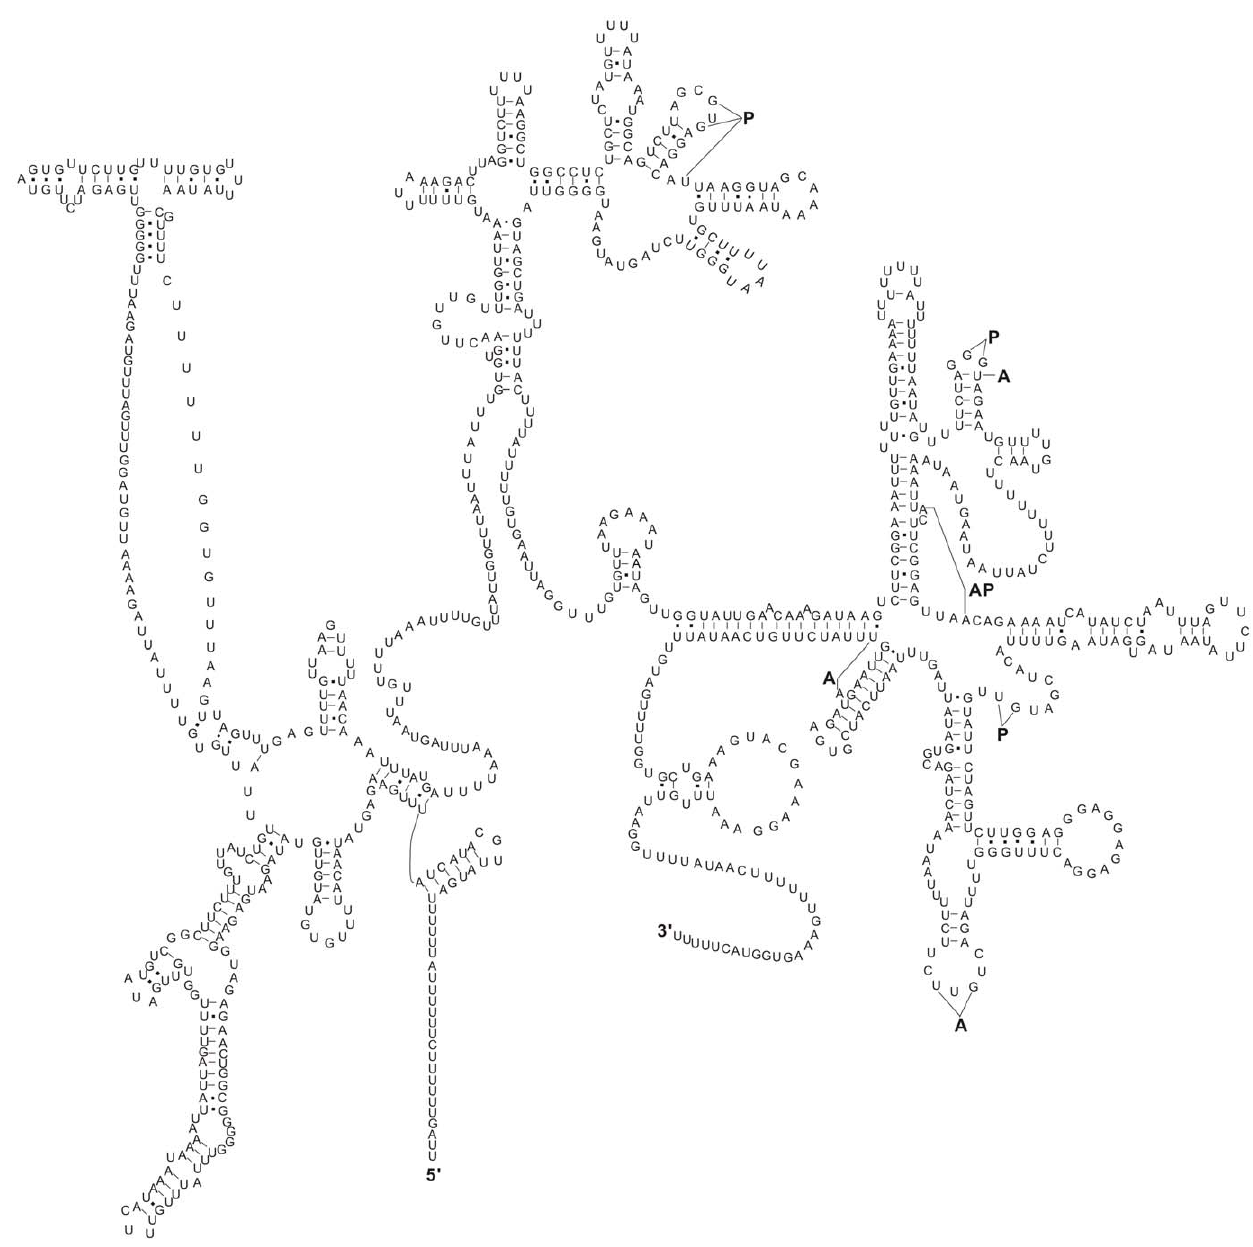
Figure 3. Predicted secondary structure for the large ribosomal RNA gene subunit ( rrn L) in B.procyonis mtDNA. Symbols for base- pairings are as in Figure 2. Binding sites for the amino-acyl trn (A), peptidyl-transferase (P) or both (AP) [54] are indicated by lines.